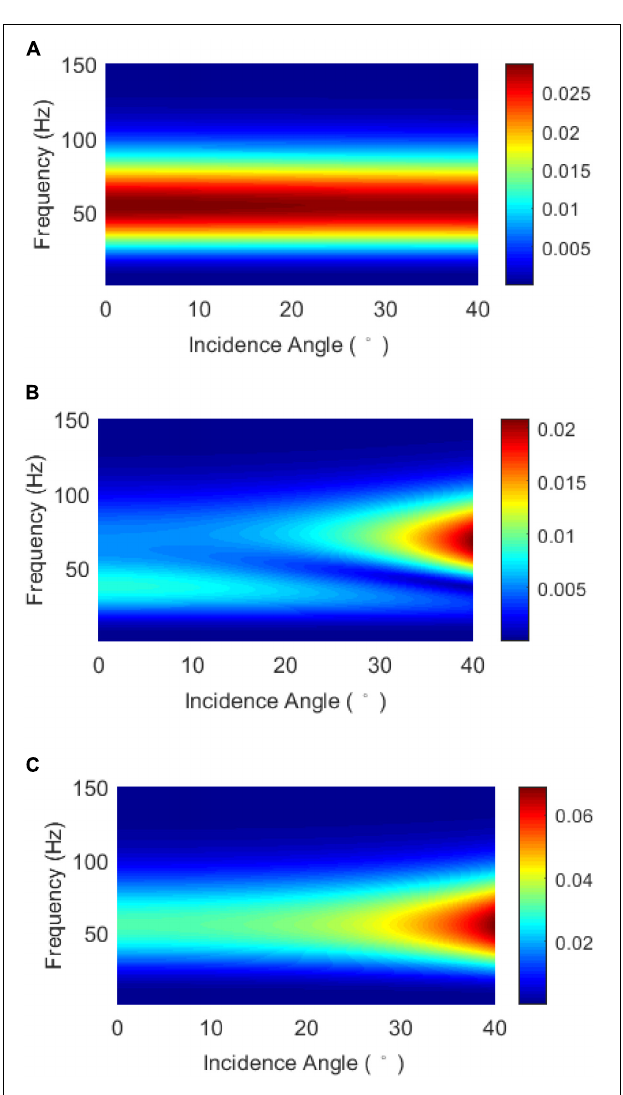
FIGURE 5 | Amplitude spectra of the PP reflection waves for gas saturations of (A) 1, (B) 0.6, and (C) 0.